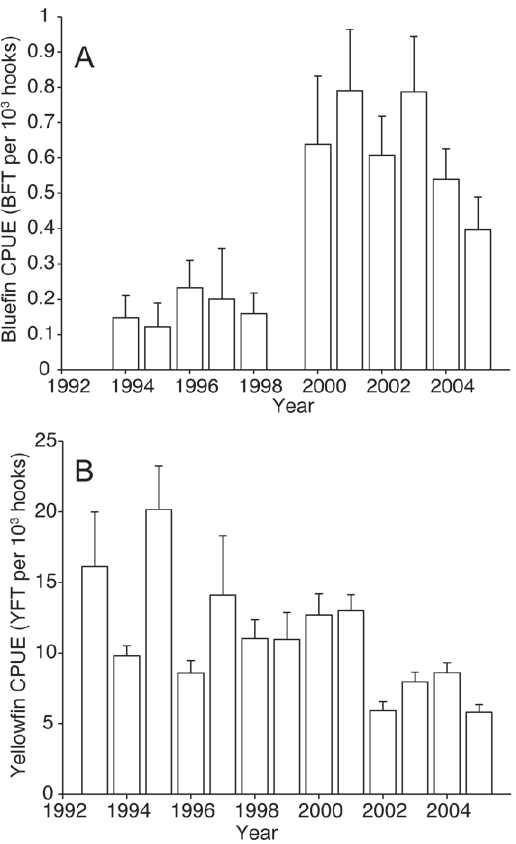
Figure 5. Bluefin tuna CPUE in relation to sea surface height anomaly and sea surface temperature. Histograms show mean catch per unit effort (CPUE) of bluefin tuna in the Gulf of Mexico, with respect to (A) sea surface height anomaly, and (B) sea surface temperature of the longline set. Error bars indicate 1 sd (based on 1000 bootstrap samples).